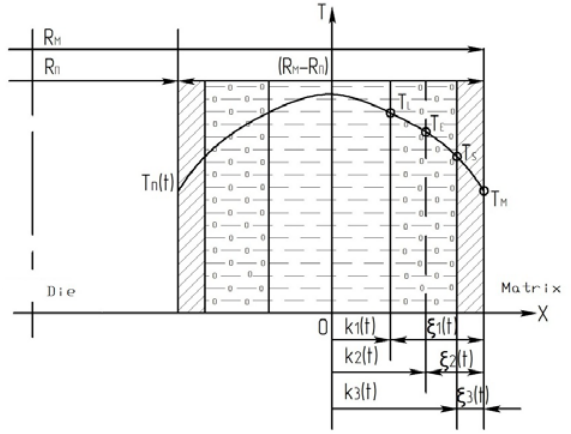
Fig. 1. The process of solidification of a hollow forging in the two-phase zone: temperature fields: TL – liquidus temperature; TE - the temperature of the conventional solidification front; TS – solidus temperature; Тп(-x,t)=Тм(x,t)=Тш(t) is the temperature of the punch and die matrix; geometric parameters: Rм, Rп – the radii of the die and punch; s=Rм-Rп – the thickness of the forging wall; ξ(t) – the thickness of the solid crust; k1(t), k3(t) – the coordinates of the fronts of the beginning and the end of crystallization; k2(t) - the coordinate of the conditional crystallization